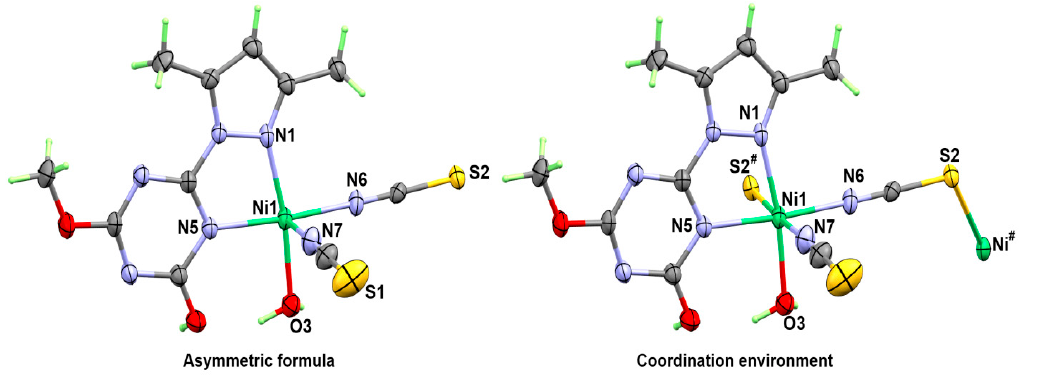
Figure 2. The X-ray structure of the [Ni(MPT)(H 2 O)(SCN) 2 ] n complex. Symmetry code #: x,1.5 − y,1/2 + z . Table 1. Crystallographic data for the [Ni(MPT)(H 2 O)(SCN) 2 ] n